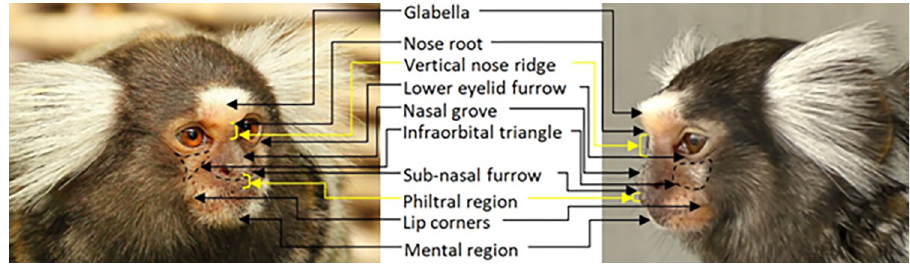
Fig 5. Facial landmarks in common